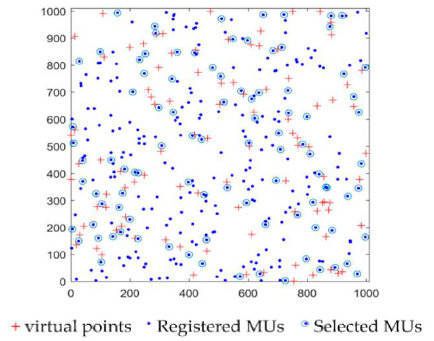
Figure 2. Virtual points and selected optimal mobile users (MUs).